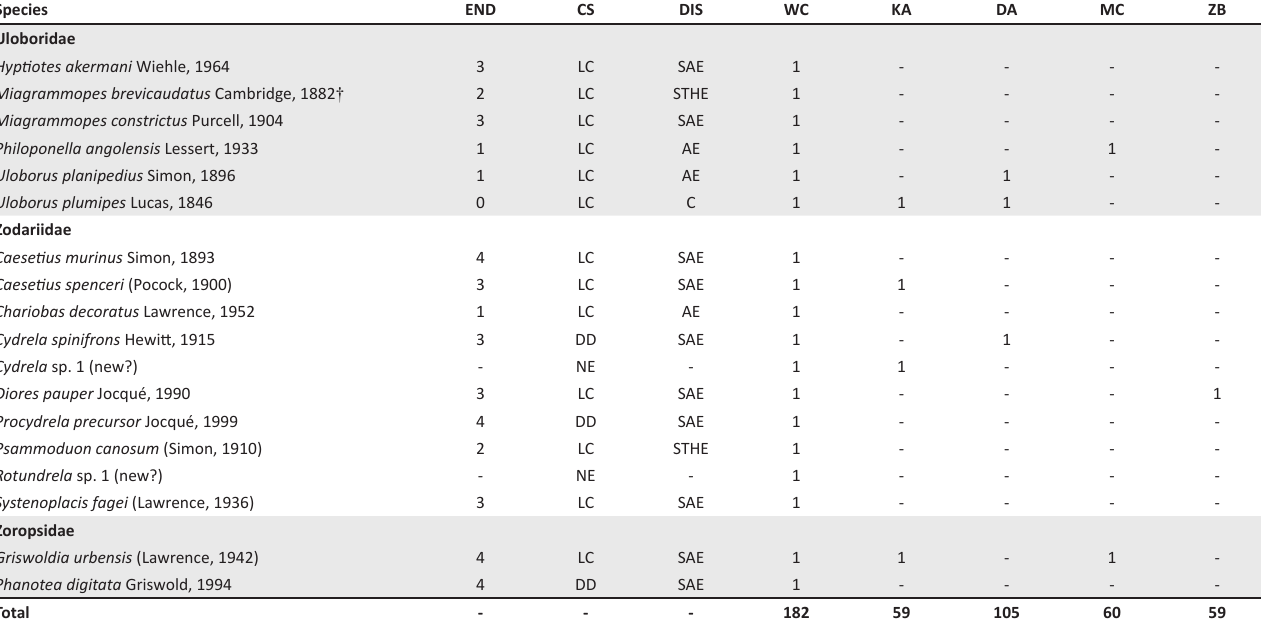
TABLE 1-A1 (Continues): Spiders of the Addo Elephant National Park, listing their endemicity, conservation status, distribution and areas sampled in the park. Species END